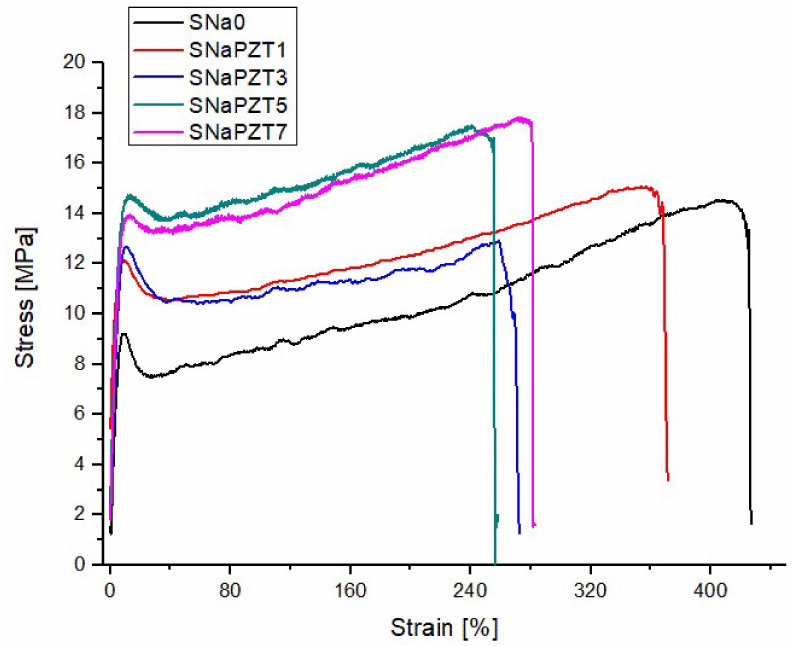
Figure 14. Tensile stress–strain engineering curves for SNa0 and SNaPZT# films. Table 4. Mechanical properties of SNa0 and SNaPZT# films obtained from the tensile stress–strain engineering